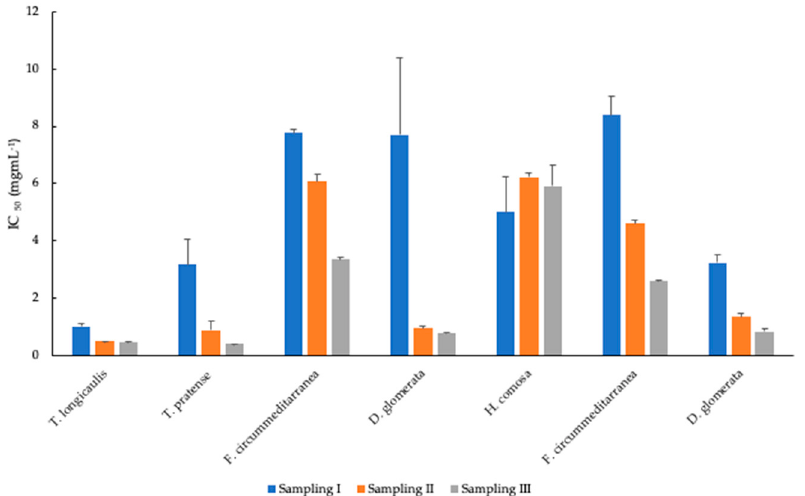
Figure 1. The dependence of IC 50 values of investigated plants, which is inversely related to the antioxidant activities. For this evaluation, only plants available at all three sampling times were considered. F. circummediterranea and D. glomerata were reported twice because they were collected from two different areas (Guardata and Guado Cannavina, respectively). A low value of IC 50 indicates a strong antioxidant activity since low concentrations of extract are able to inhibit 50% of the radical reaction [32].